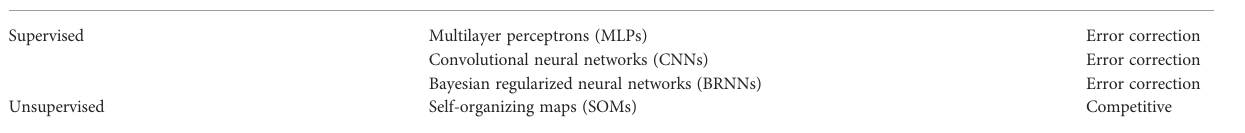
TABLE 1 The neural network